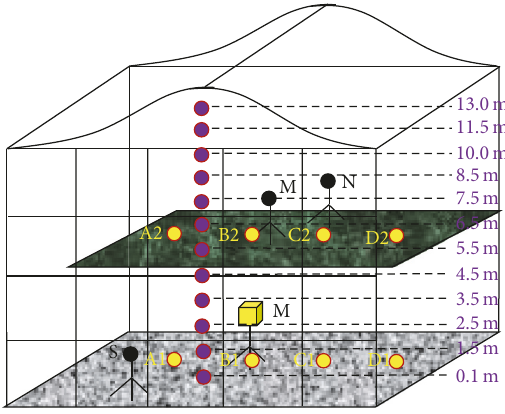
Figure 4: Measuring point